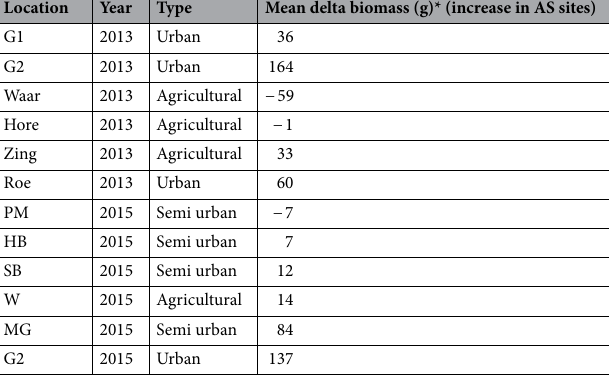
Table 2. Mean biomass increase in AS sites. *Sum of biomass increase in AS sites minus sum of biomass increase in AD sites; divided by the numbers of nests per site (3). AS = apiary sparse; AD = apiary dense.